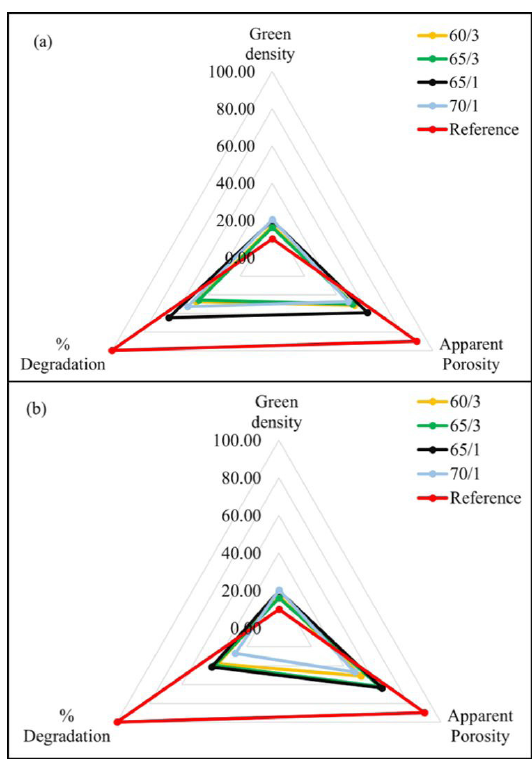
Figure 10. Radar chart for compositions 60/3, 65/3, 65/1, and 70/1 heat-treated at (a) 800 °C/2 h and (b) 1000 ºC/2 h regarding the evaluated properties.